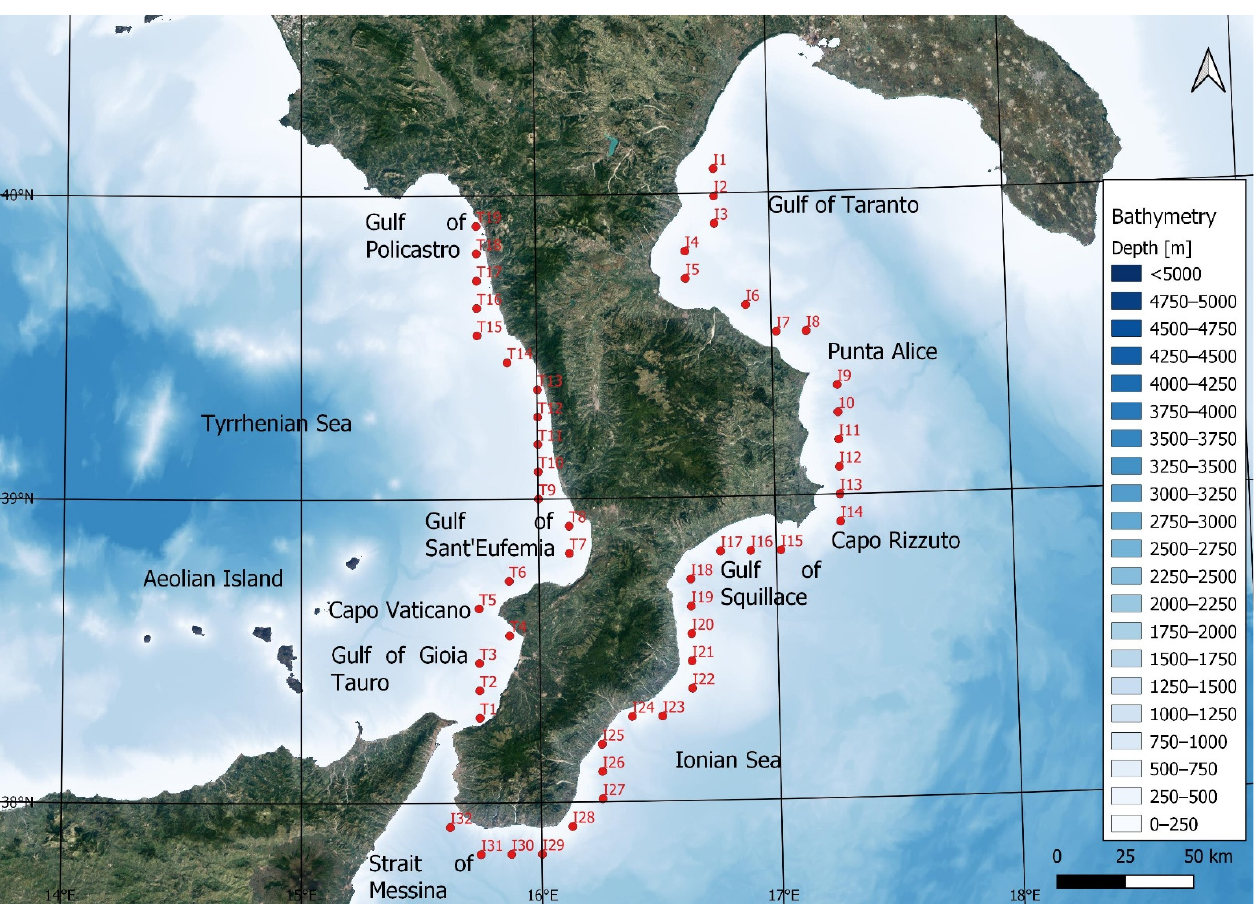
Figure 2. Calabrian sample areas, identified with the suffix I for the points of the Ionian Sea and with the suffix T for the points of the Tyrrhenian Sea, both followed by an increasing number in a clockwise direction.